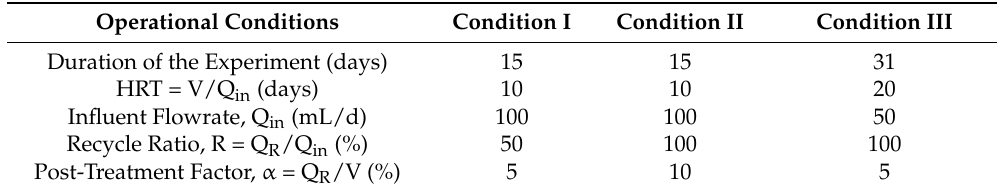
Table 2. Operational conditions of each